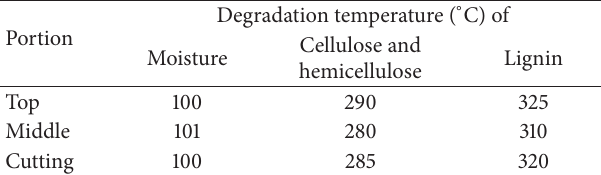
Table 1: Thermal properties of different portions of jute fiber.